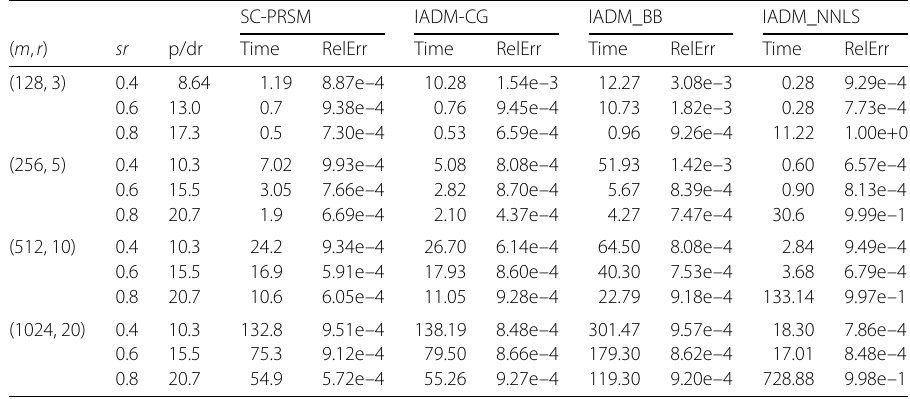
Table 1 SC-PRSM, IADM-CG, IADM_BB, IADM_NNLS for solving the easy nuclear norm minimization,